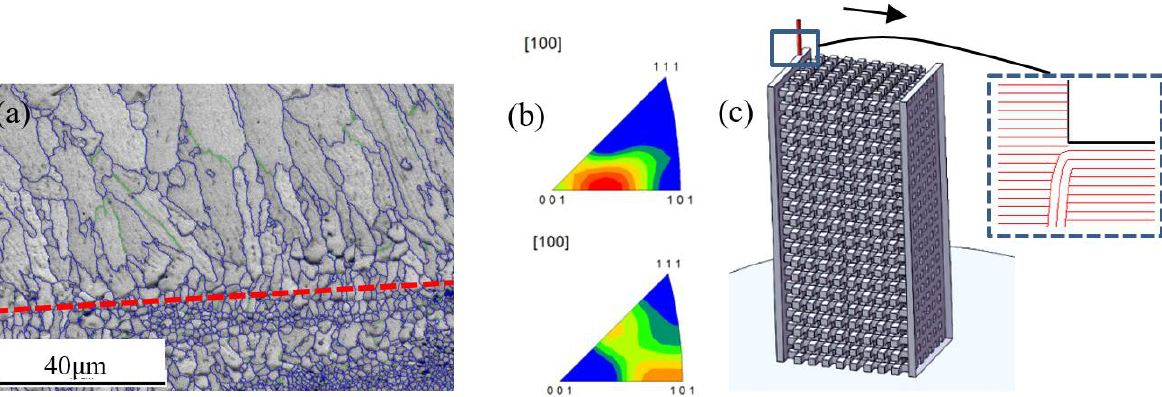
Figure 10. Grain structure on different spots: ( a ) spot P1; ( b ) P1 and P2 located in specimen; ( c ) spot P2.